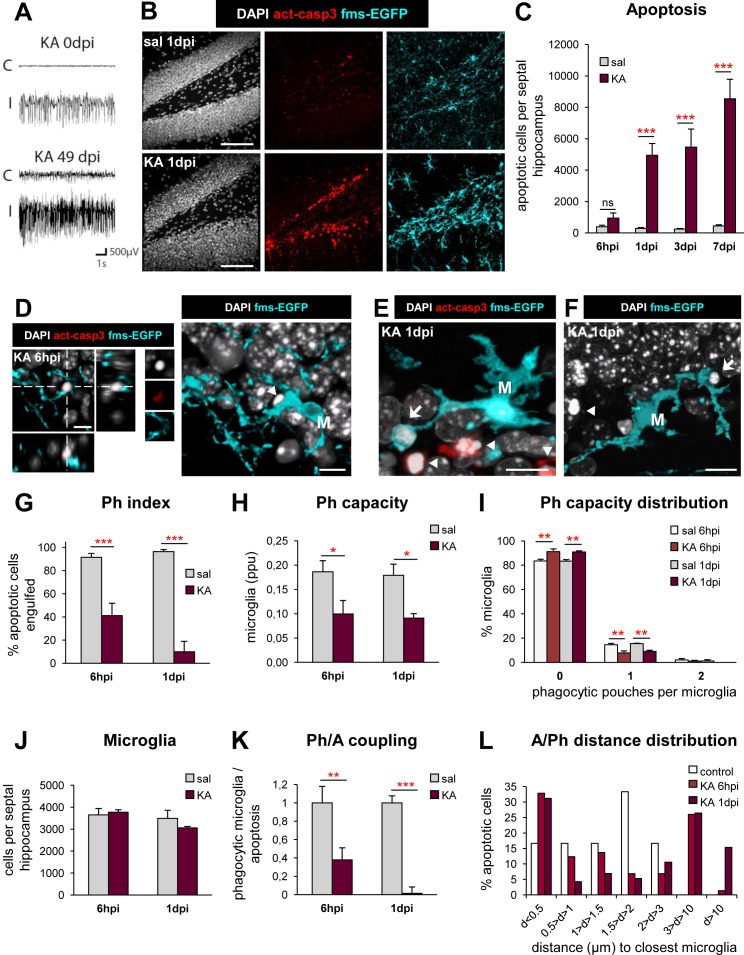
Microglial phagocytosis is impaired early (1 dpi) due to MTLE seizures in vivo.(A) Hippocampal electroencephalographic recordings of mice injected in the ipsilateral side (I) with KA (50 nL, 20 mM) during status epilepticus (0 dpi) and during a spontaneous seizure occurring in the chronic phase of MTLE (49 dpi). The contralateral hippocampus (C) is shown for comparison purposes. (B) Representative confocal z-stacks of saline and KA (1 dpi) hippocampi labeled with DAPI (nuclear morphology, white), activated caspase 3 (act-casp3+, red, for apoptotic cells), and fms-EGFP (cyan, microglia). (C) Number of apoptotic cells (pyknotic/karyorrhectic and act-casp3+) in the septal DG (n = 3−9 per time point and treatment). The volume of the septal DG is shown in S3B Fig. (D) Representative confocal image of a nonphagocytosed apoptotic (pyknotic and act-casp3+, arrowhead) cell in the SGZ (orthogonal projection, left; and 3-D-rendered image, right). M, microglial cell body. (E) Representative 3-D-rendered confocal z-stack of apoptotic (pyknotic and act-casp3+) cells, phagocytosed (arrow) or not (arrowheads) in the septal DG of mice treated with KA at 1 dpi. M, microglial cell body. (F) Representative 3-D-rendered confocal z-stack of an apoptotic (pyknotic), nonphagocytosed cells (arrowhead) in the DG of mice treated with KA at 1 dpi. The arrow points to a semiengulfed apoptotic cell. M, microglial cell body. (G) Ph index in the septal DG (in % of apoptotic cells) after KA. Phagocytosis by astrocytes and neuroblasts is shown in S3C and S3E Fig. (H) Weighted Ph capacity of DG microglia (in ppu). (I) Histogram showing the Ph capacity distribution of microglia (in % of cells) in the DG. (J) Total number of microglial cells (fms-EGFP+) in the septal DG. Microglial density is shown in S3A Fig. (K) Ph/A coupling (in fold change) in the septal DG. (L) Histogram showing the distribution of the distance (in μm) of apoptotic cells (in %) to microglial processes. The average distance of apoptotic cells to microglia is shown in S3F Fig. Bars represent mean ± SEM except in L, where they indicate the sum of cells in each distance slot. * indicates p < 0.05, ** indicates p < 0.01, and *** indicates p < 0.001 by Holm-Sidak posthoc test after two-way ANOVA (H–K) or one-way ANOVA (C, G, where a significant interaction time x treatment was found) were significant at p < 0.05. Scale bars = 50 μm (B), 10 μm (D–F). z = 25 μm (B), 13.9 μm (D), 14.1 μm (E), 8.4 μm (F). Underlying data is shown in S1 Data.